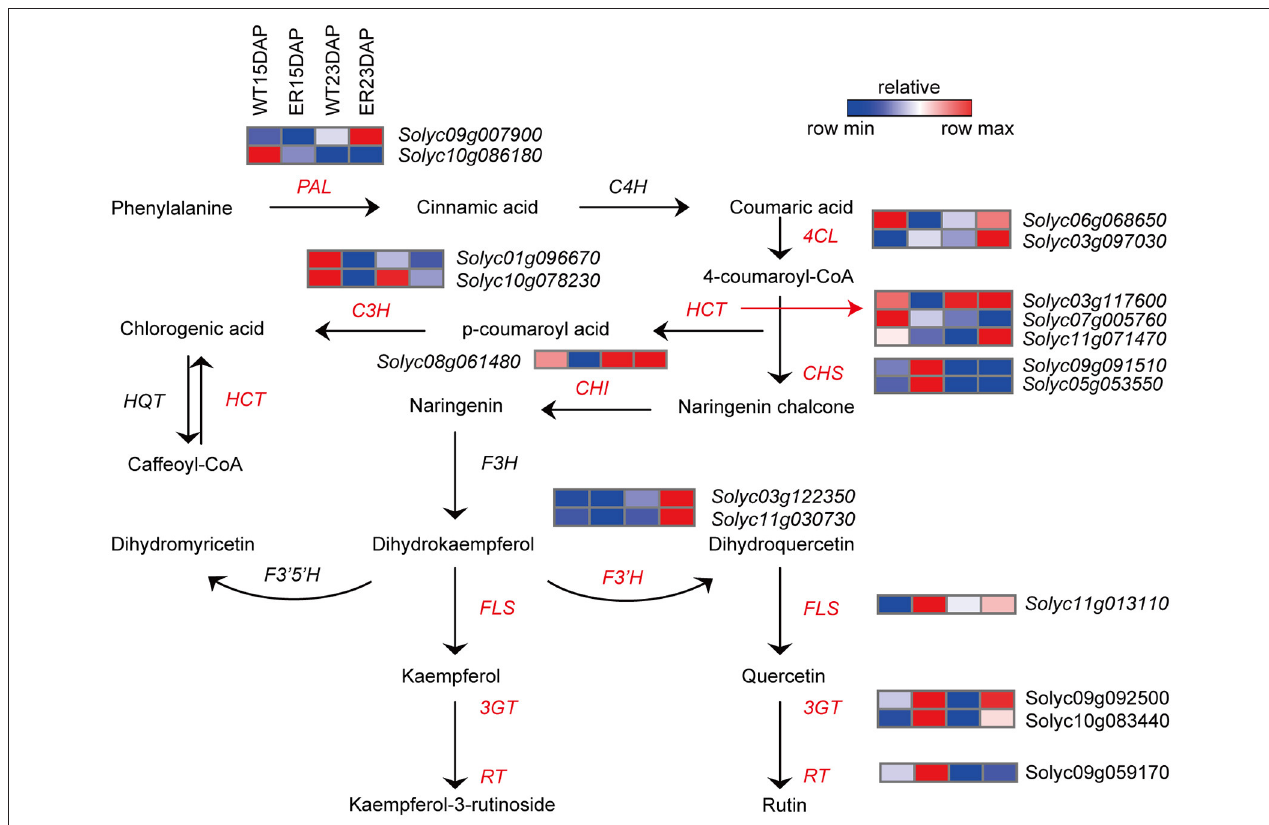
FIGURE 6 | Analysis of differentially expressed genes (DEGs) involved in the flavonoid biosynthesis pathway between epidermal reticulation (ER) and WT fruit exocarp. Schematic diagram of the flavonoid biosynthesis ( Ballester et al., 2010) and the expression profile of DEGs encoding key enzymes in the pathway. The FPKM (fragments per kilobase of transcript per million mapped reads) value is the average of three biological replicates. Abbreviations are listed in Table